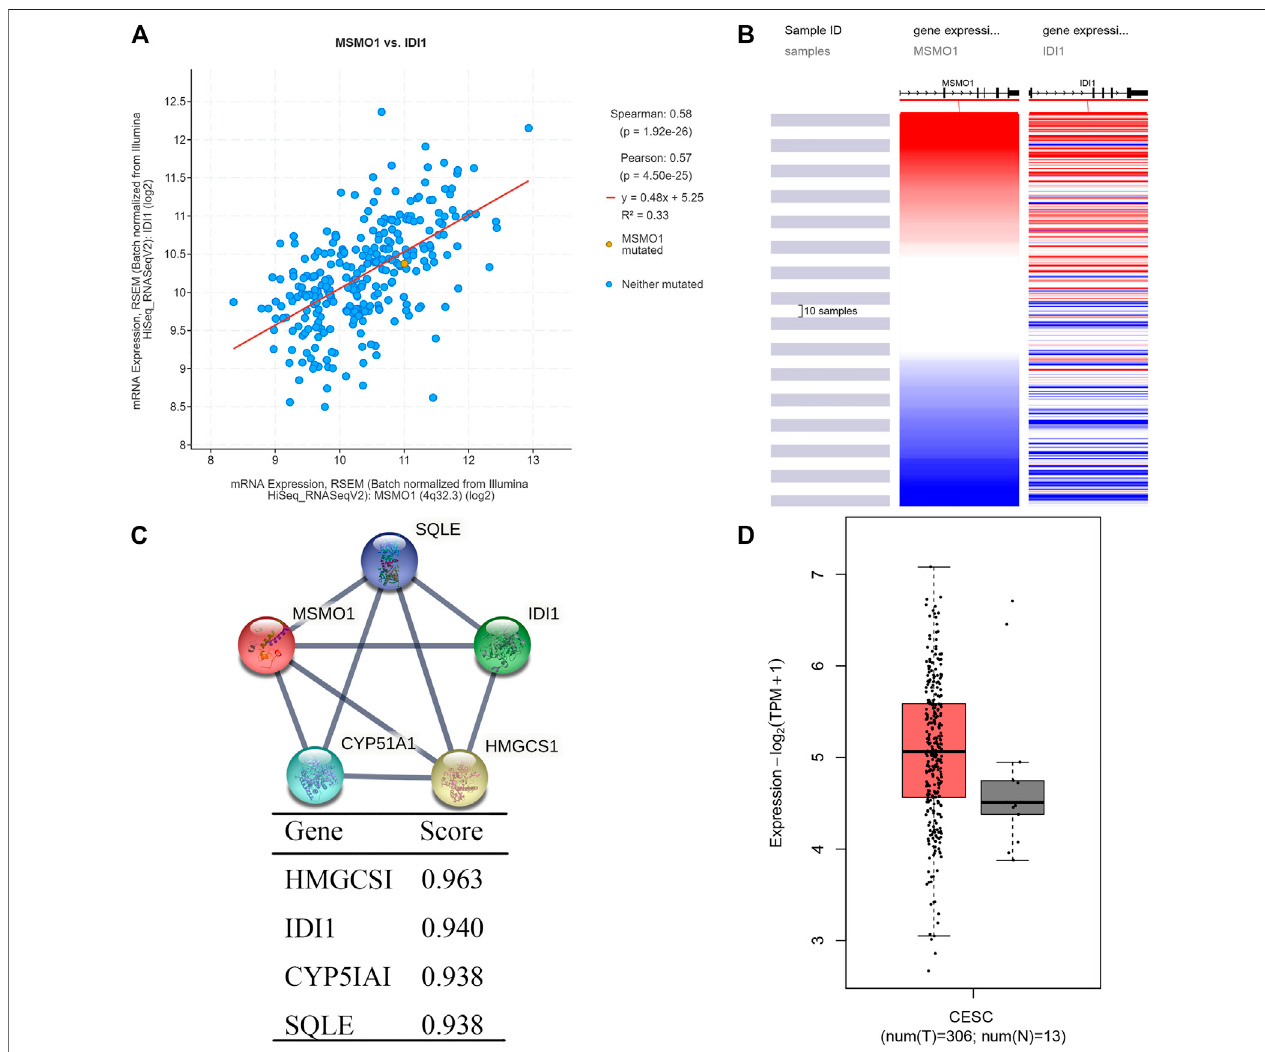
FIGURE 8 | Analysis of co-expressed genes with MSMO1. (A) Schematic diagram of the correlation between IDI1 gene and MSMO1 co-expression in cBioPortal. (B) Heatmap ofIDI1andMSMO1 expressioninUCSCXena. (C) Theinteractionnetworkdiagramofco-expressedproteinswithMSMO1inSTRING. (D) InGEPIA2, the expression difference map of the IDI1 gene in